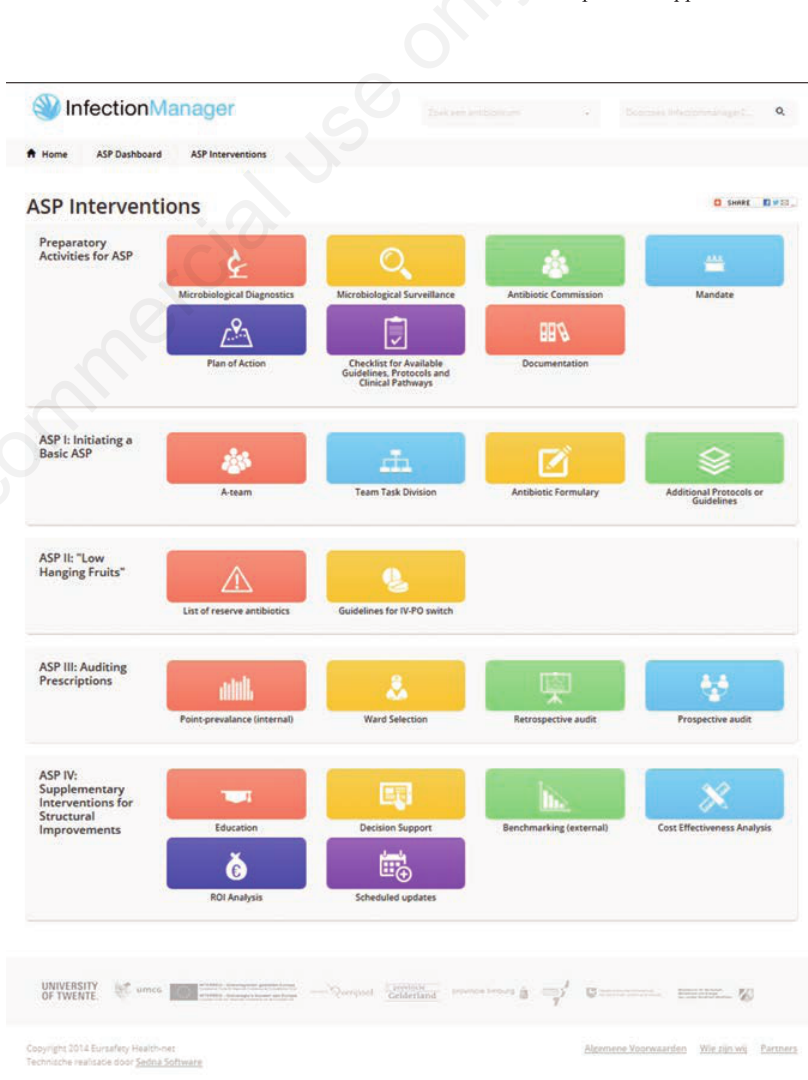
Figure 2. The Maturity model.